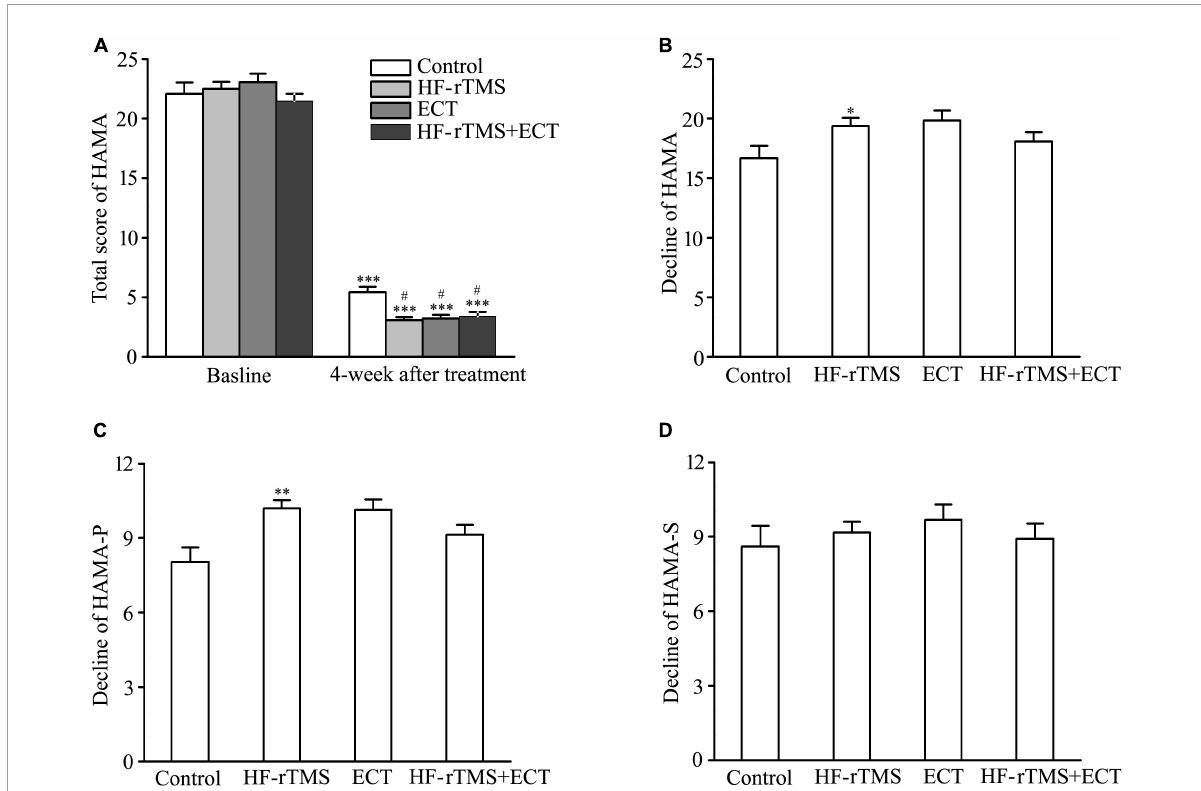
FIGURE3 Effect of non-invasive brain stimulation (NIBS) on anxiety detected by HAMA-14 at baseline and 4-week after treatment. (A) Total scores of HAMA-14 at baseline and 4 weeks after treatment. ∗∗∗ p < 0.001, compared with baseline levels; # p < 0.001, compared with control at 4-week after treatment. (B) Decline in total scores of HAMA-14 from baseline to post-intervention at 4 weeks. ∗ p < 0.05, compared with control. (C,D) Decline in scores of two factors in HAMA-14. HAMA-P (C) , HAMA-S (D) . ∗∗ p < 0.01, compared with control. Graphs show mean ± SEM.